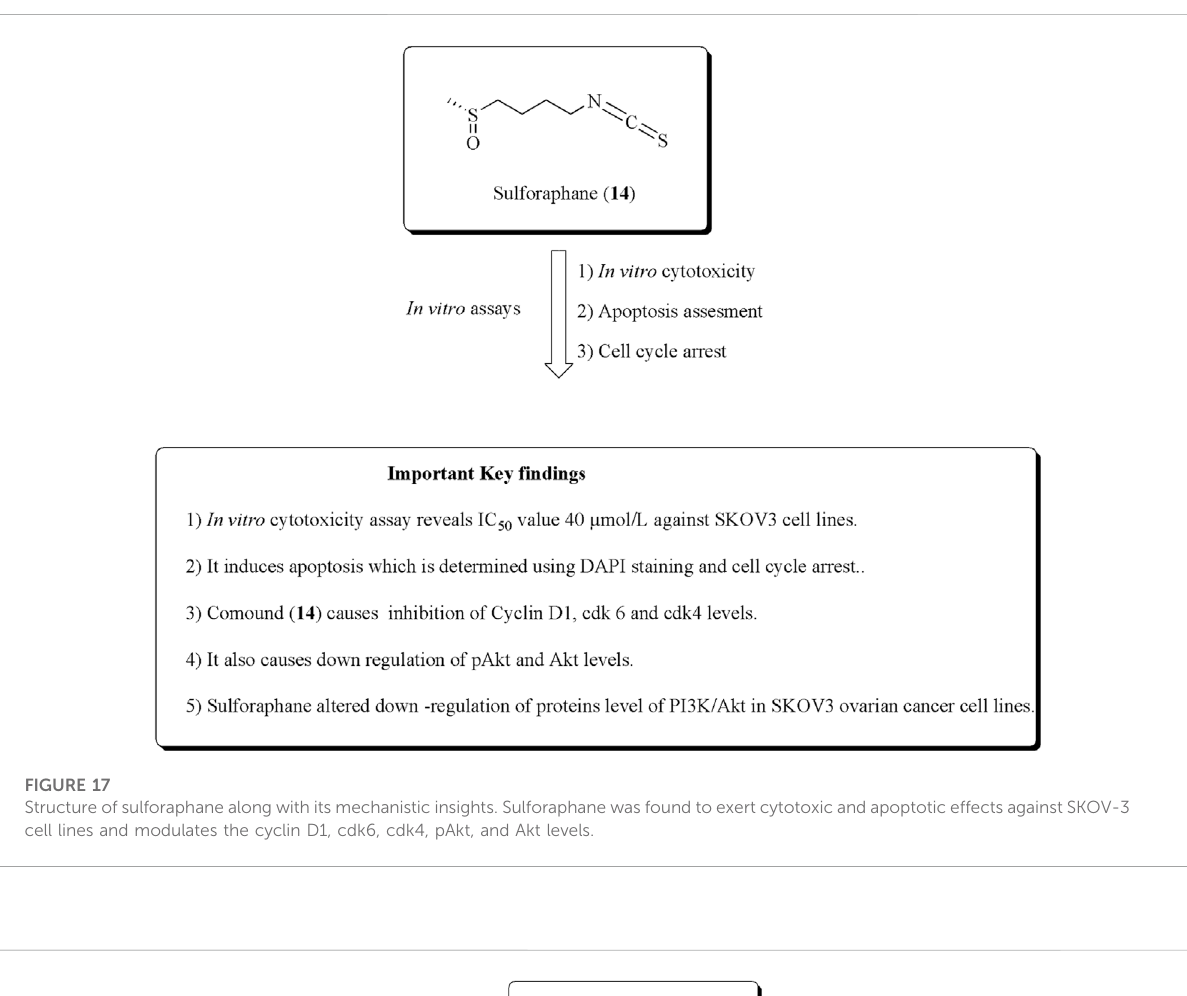
FIGURE 17 Structure of sulforaphane along with its mechanistic insights. Sulforaphane was found to exert cytotoxic and apoptotic effects against SKOV-3 cell lines and modulates the cyclin D1, cdk6, cdk4, pAkt, and Akt levels.